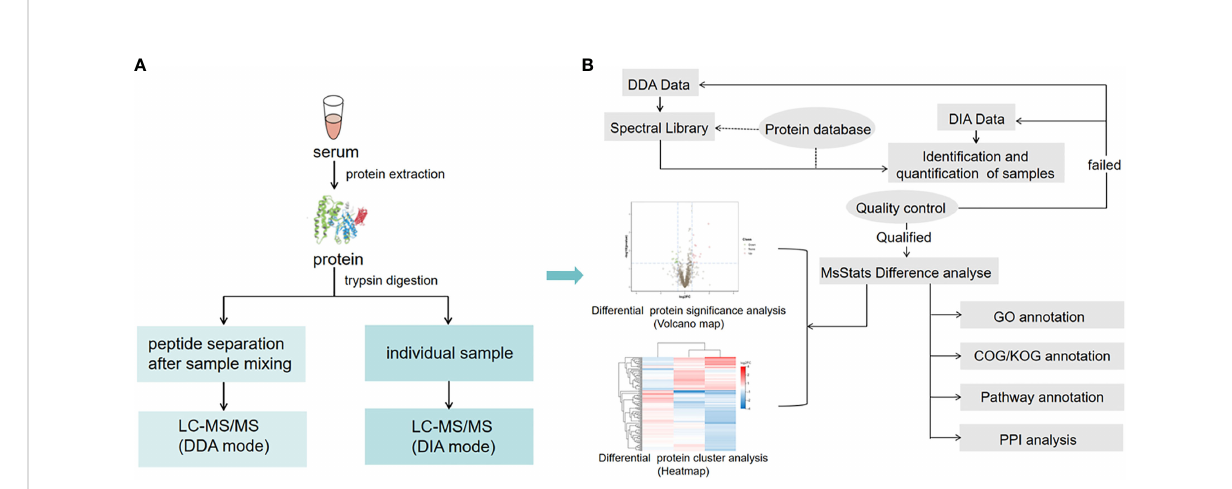
FIGURE 1 Serum sample DIA and DDA analysis work fl ow. (A) The main experimental work fl ow. Q-Exactive HF X was used to acquire mass spectrometry data for 60 samples in DIA mode. (B) Bioinformatics pipeline. This process is based on the sample data generated from the high-resolution mass spectrometer. Principal component analysis (PCA) and quantitative correlation of samples were also performed to evaluate the quality of the DIA data. For bioinformatics analysis, GO, COG, functional pathway annotation, and PPI analysis were performed in this